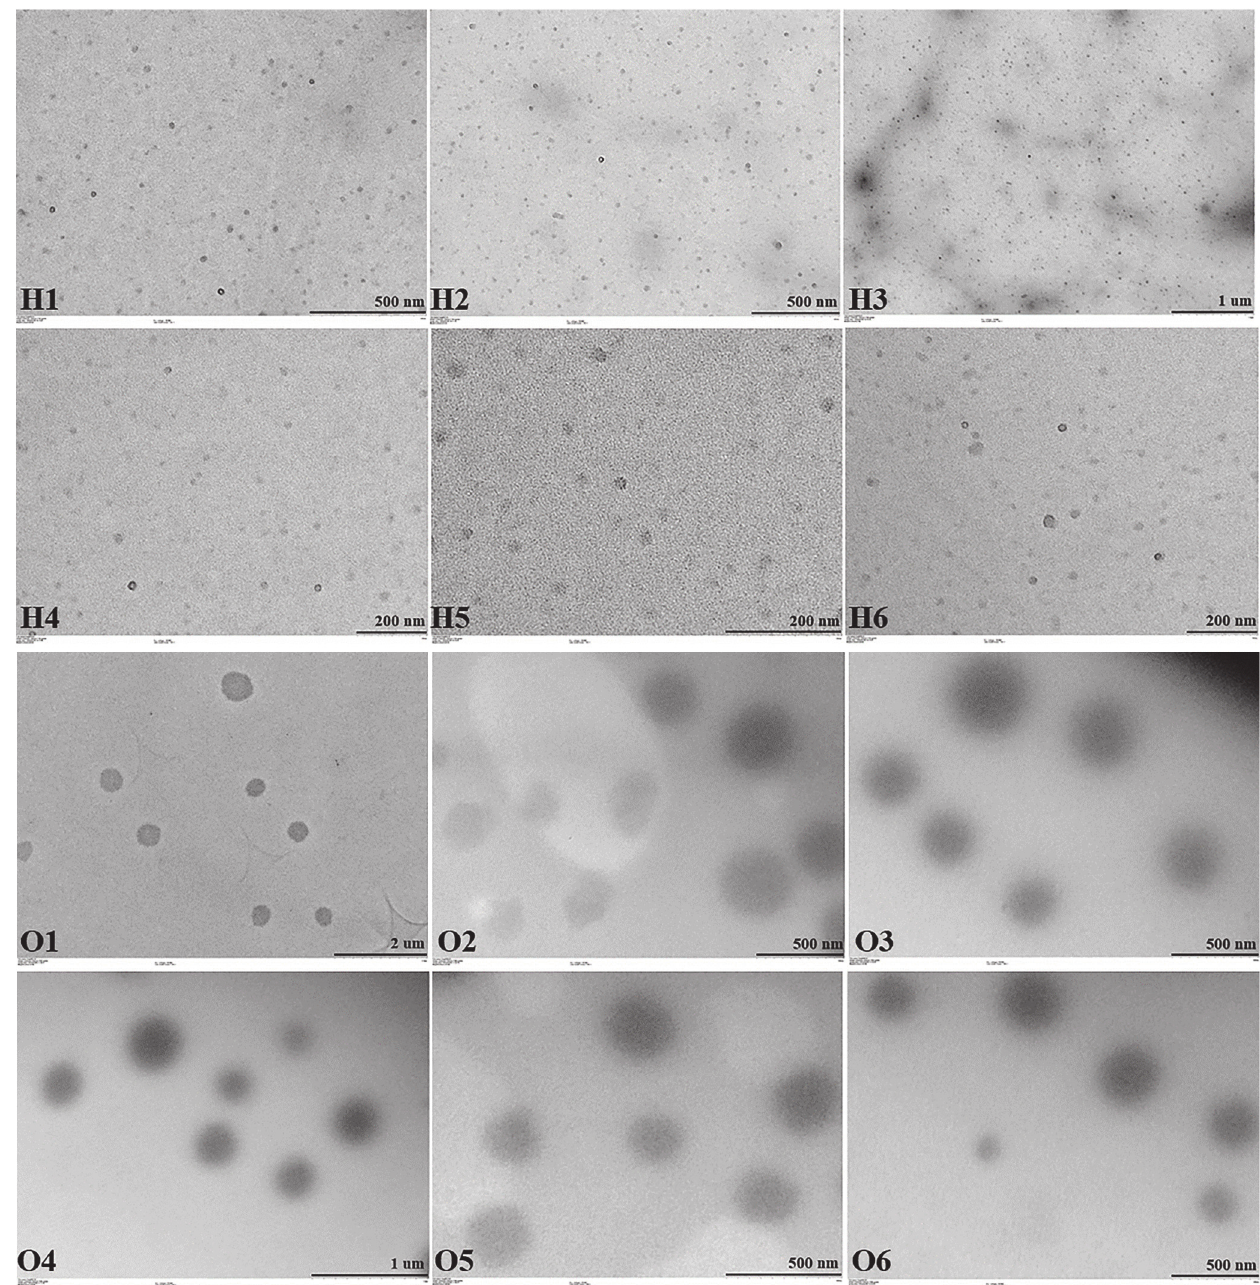
Figure 4. TEM images of hydrogels and organogels. Hydrogels are coded with letter H and organogels with the letter O.